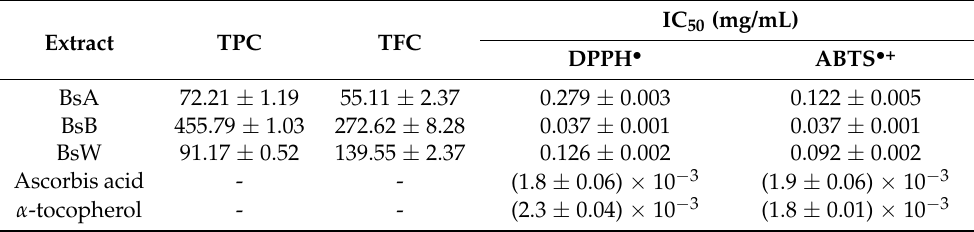
Table 3. Results for TPC (mg/g gallic acid equivalents), TFC (mg/g quercetin equivalents), and IC 50 (mg/mL) for the antioxidant activity of the different fractions of B. saxatilis from Jordan. Extract